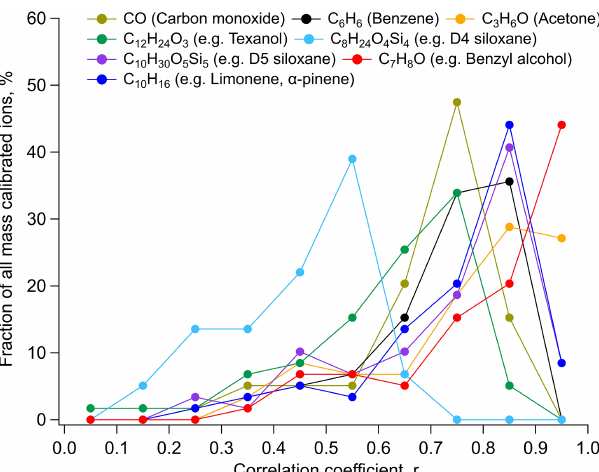
Figure 6. A comparison of correlations to major tracer compounds. Distributions of correlation coefficients (using hourly average data) for Table 1 compounds against select prominent compounds used as markers of VCP-related sources or general anthropogenic emissions (e.g., CO, benzene). Results binned into 0.1 intervals; for example, ∼ 45% of compounds were highly correlated at 0 . 9 < r < 1 with C 7 H 8 O (i.e., benzyl alcohol). See SI for similar analysis, including all uncalibrated target ions and correlation comparisons for all target compounds (Figs. S14–S17 and